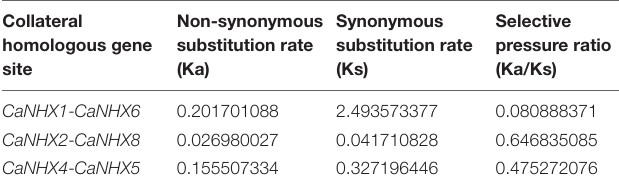
Collateral homologous